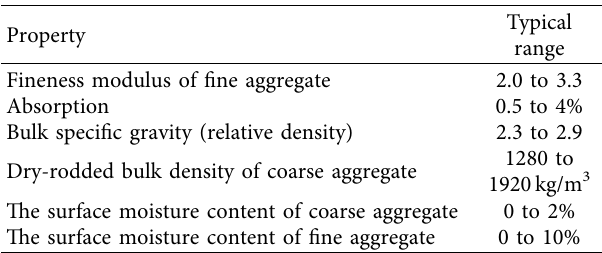
Table 2: Summary of the physical properties of aggregates com- monly used in